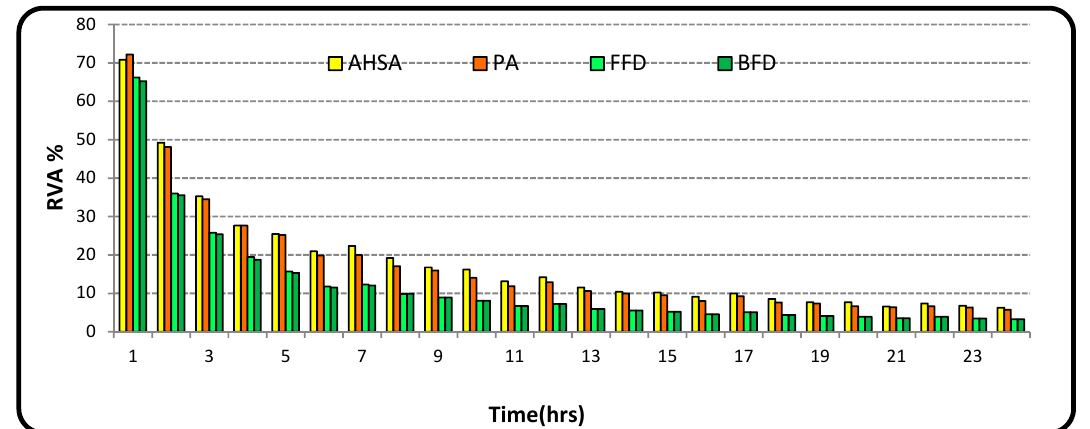
Figure 4. Ratio of virtual machine acceptance percentage (RVA%) - Scenario I.